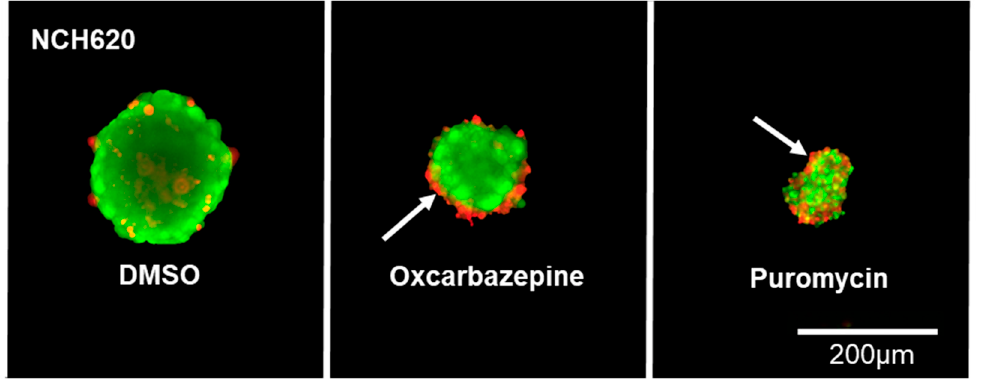
Figure 4. Antiproliferative effect of oxcarbazepine in NCH620. Representative GSC spheroids. After dissociation into a single-cell suspension, oxcarbazepine was added and stained using live/dead staining, showing a reduced size (growth inhibition) upon treatment with oxcarbazepine (30 µ M) compared to the DMSO and puromycin (4 µ M) controls. Dead cells (red) seem to accumulate at the surface of the treated spheroids, suggesting that oxcarbazepine induces apoptosis and that dead cells are being shuttled outward before being shed (white arrow).